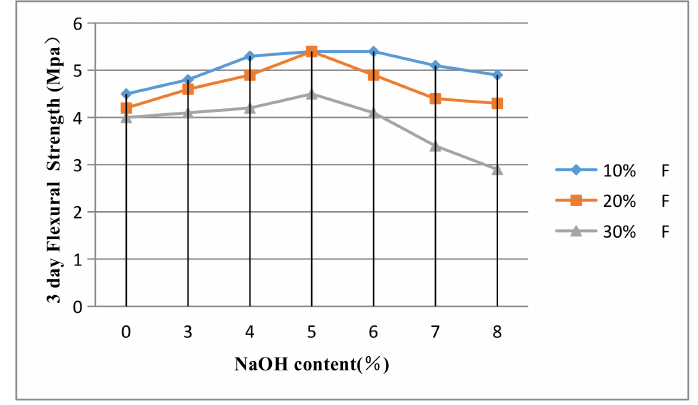
Figure 2. NaOH content–flexural strength curves at 3 days.